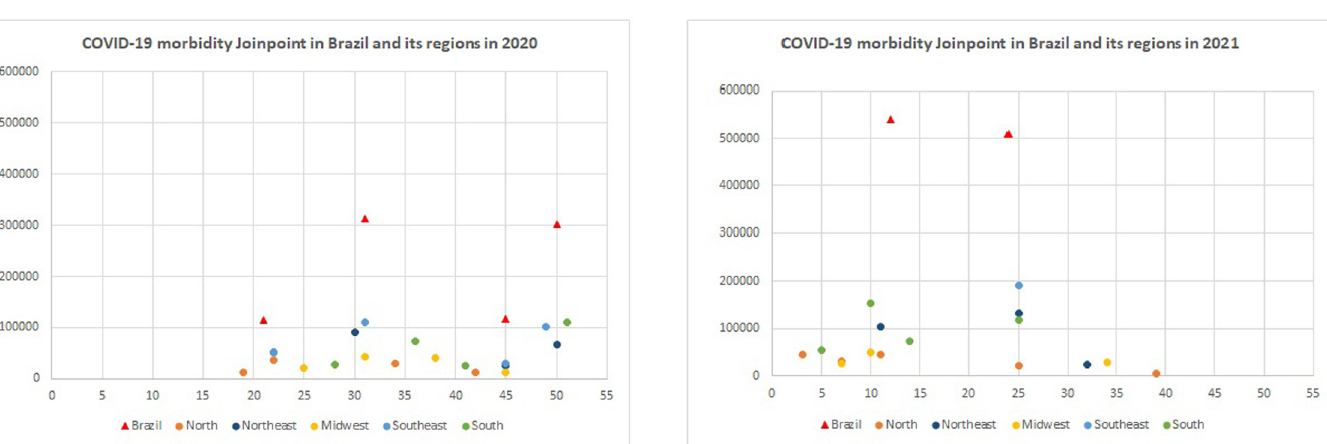
PLOS ONE | https://doi.org/10.1371/journal.pone.0268169 September 22,